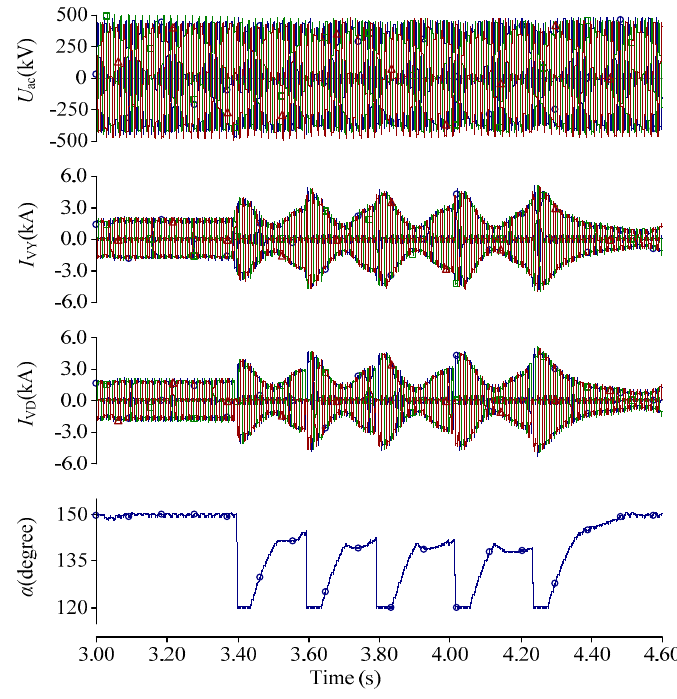
Figure 16. The test waveform before the optimization of the commutation failure prediction. Figure 17 is a test waveform applied to an improved commutation failure prediction algorithm.